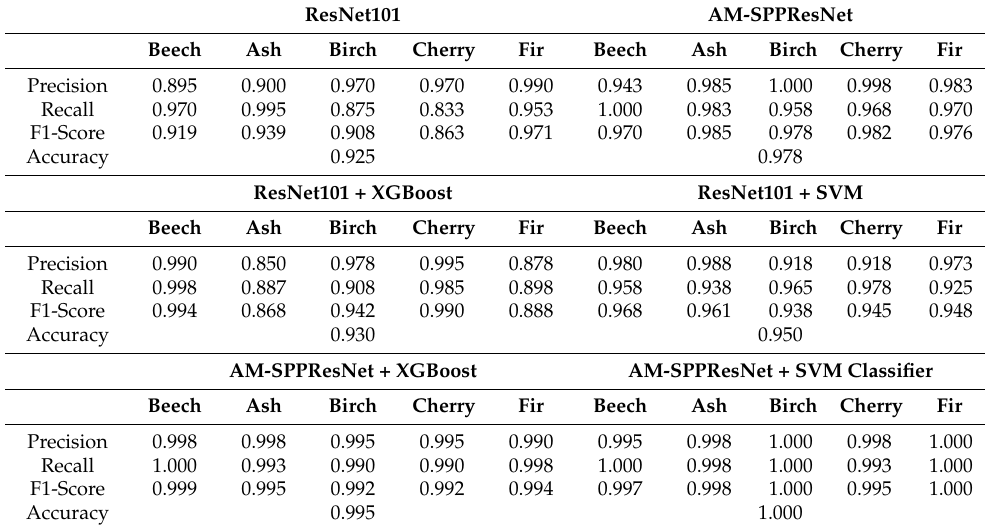
Table 3. Identification performance of SVM and XGBoost on AM-SPPResNet feature.